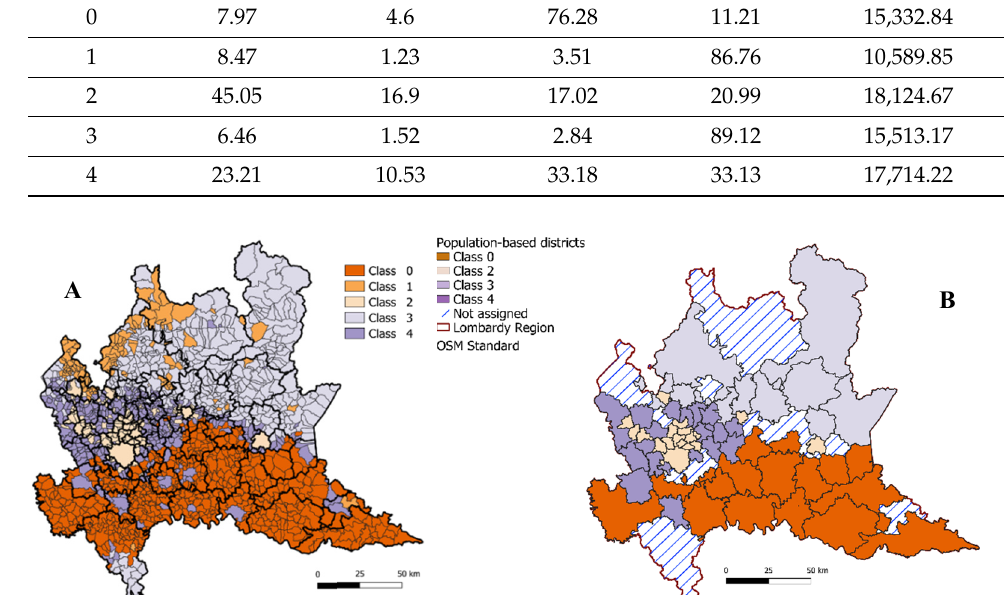
Figure 4. ( A ) Map of Lombardy region with each of the municipality administrative boundaries highlighted (thin black lines), as well as the boundaries of generated 77 districts of approximatively 100,000 residents (bold black lines). The color attributed to each municipality reflects the results of the mapping operation with the corresponding territorial clustering class (see text for details). ( B ) Map of Lombardy region with the boundaries of generated 77 districts superimposed. The color attributed to each district is the result of the mapping operation with the corresponding territorial clustering class (see text for details). Class 0: prevalently agricultural; class 1: mainly natural area with lower income; class 2: mixed land utilization with prevalent urbanized areas; class 3: mainly natural area with higher income; class 4: mixed land utilization with prevalent agriculture/natural areas.